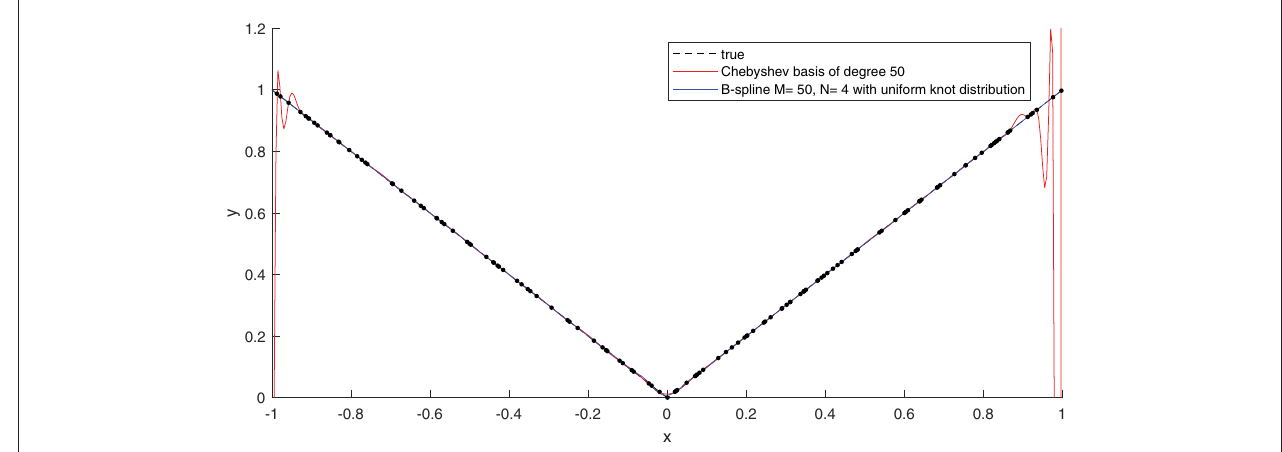
FIGURE 3 | If an ordinary least-squares objective function is used to construct an approximation, high-degree polynomials become more susceptible to the Runge’s phenomenon, resulting in wild oscillations near the boundary of the approximation interval. By keeping the order of the B-splines low, the Runge’s effects can be circumvented. Shown in the plot is a least-squares fit of the function f ( x ) distribution) to perform the regression. The samples are plotted in black